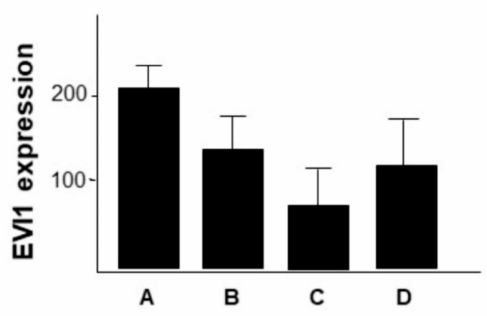
Figure 5. Correlation of EVI1 expression in di ff erent tumor tissues. A, primary tumor. B, (unmatched) lymph node metastasis. C, distant metastasis. D, local recurrence. The di ff erences in EVI1 expression were not statistically significant (unpaired t -test, p >